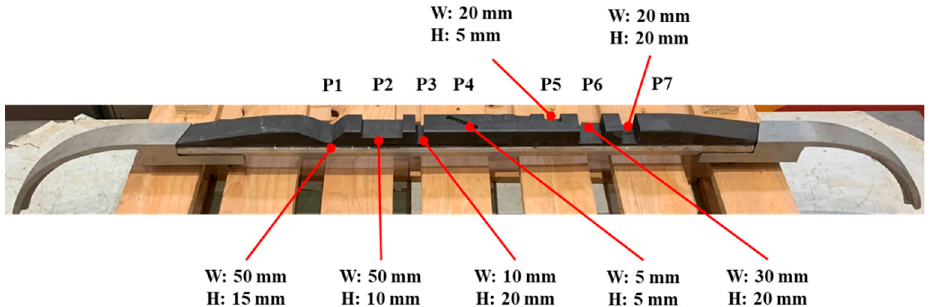
Figure 3. Physical contact strip of the simulation with sizes of the deformations.